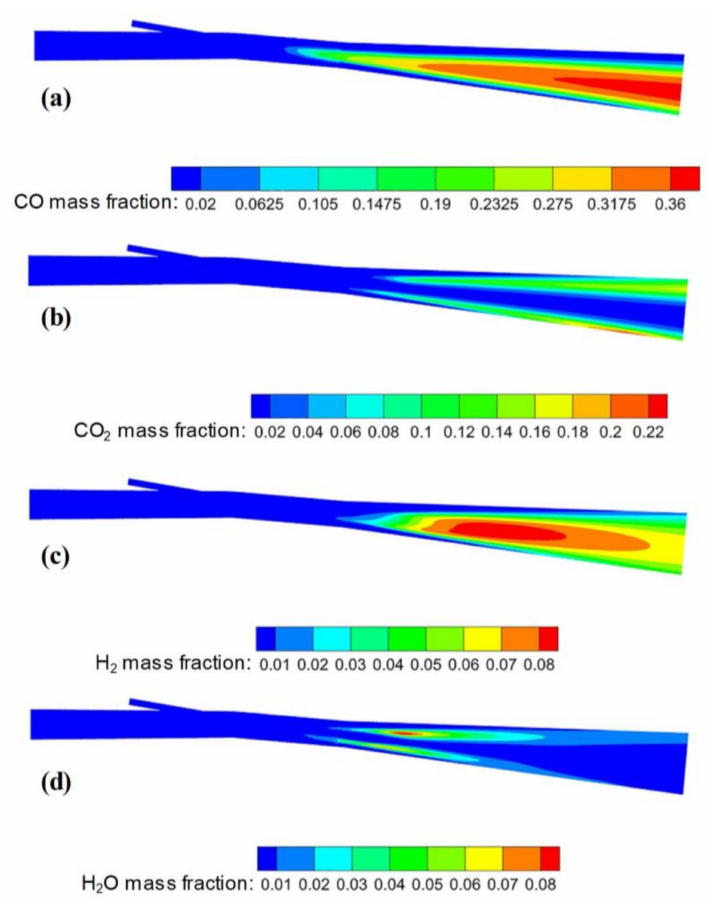
Figure 8. Gas composition distributions in blowpipe-tuyere-combustion zone: ( a ) CO, ( b ) CO 2 , ( c ) H 2 and ( d ) H 2 O.